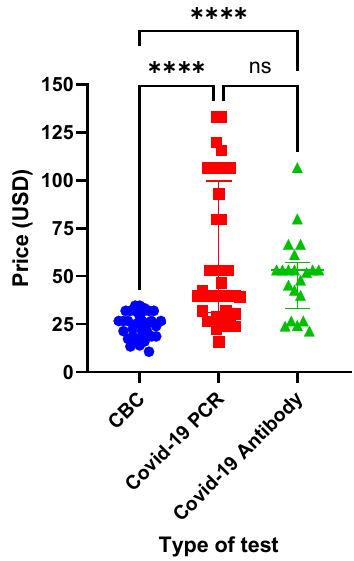
Figure 1. A comparison between the prices of the different investigations. The figure demonstrates a CBC (blue circles) to have a significantly lower price as compared to COVID ‐ 19 PCR tests (red squares) and antibody titers (green triangles). Prices are presented in USD. **** denotes a p ‐ value of <0.0001. CBC: complete blood count; ns: non ‐ significant; USD: United States dollars.